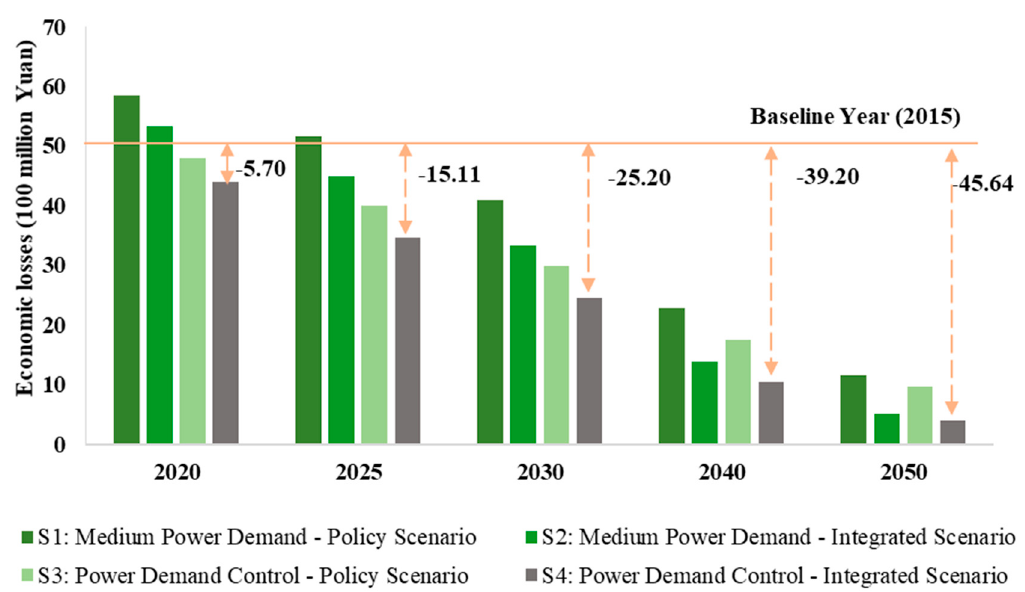
Figure 3. Health economic losses of SO 2 emissions under different scenarios in the power sector.